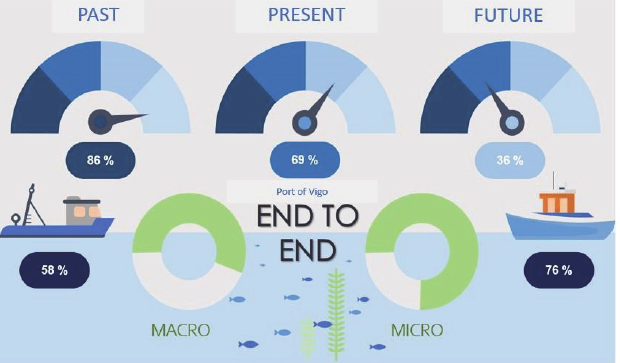
Figure 6. Past, present, and future of the Port of Vigo. Source: own elaboration. Independently analyzing each of the variables and weightings of each indicator by its value, the following graph is obtained.